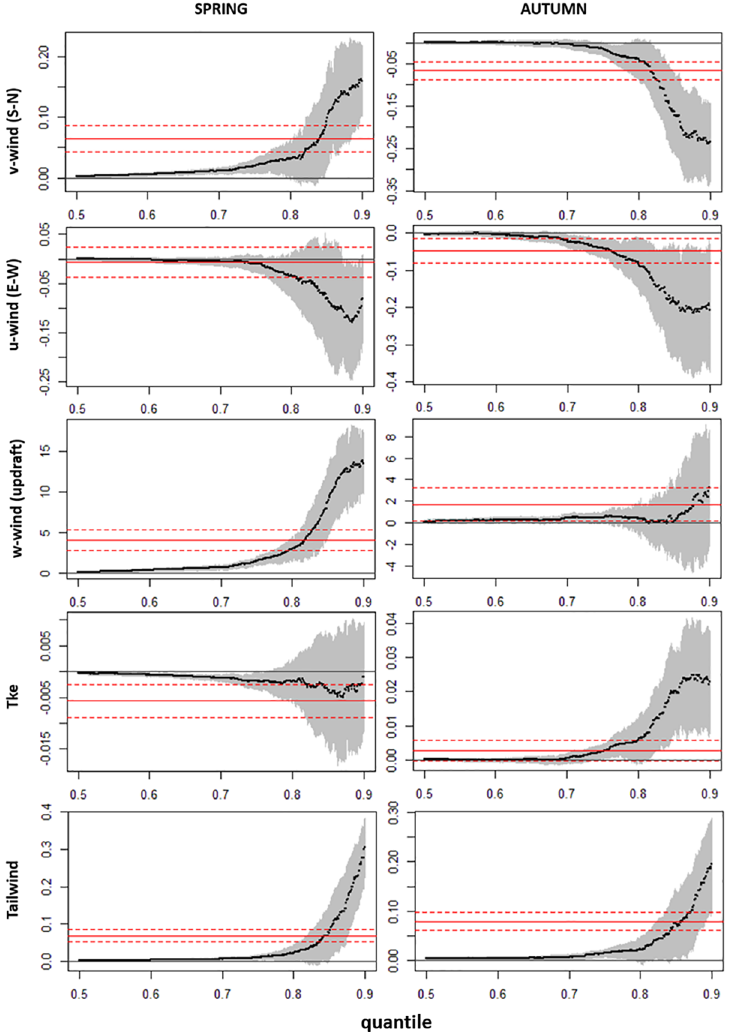
Fig 2. Results of the quantile regression analysesof the hourly flying speed of AWPE for each season and each of the environmental predictors considered. Each black dot is the slope coefficient for the quantileindicatedon the x axis. The red lines are the least squaresestimate (solid) and its 95% confidence interval(dashed). The grey area represents the 95% confidenceintervalfor the quantileregression estimates plotted as the black